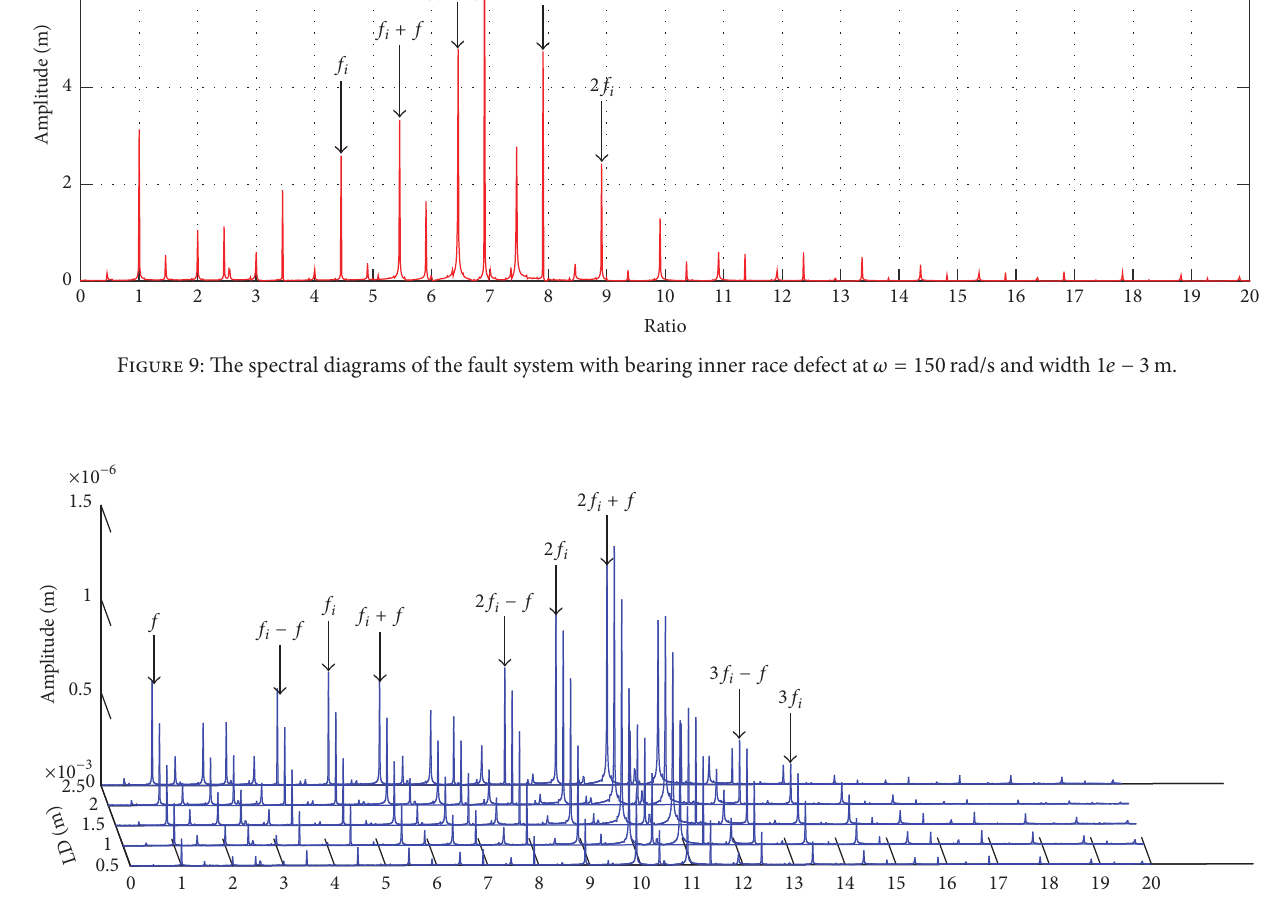
20 191817161514131211109 Ratio876543210